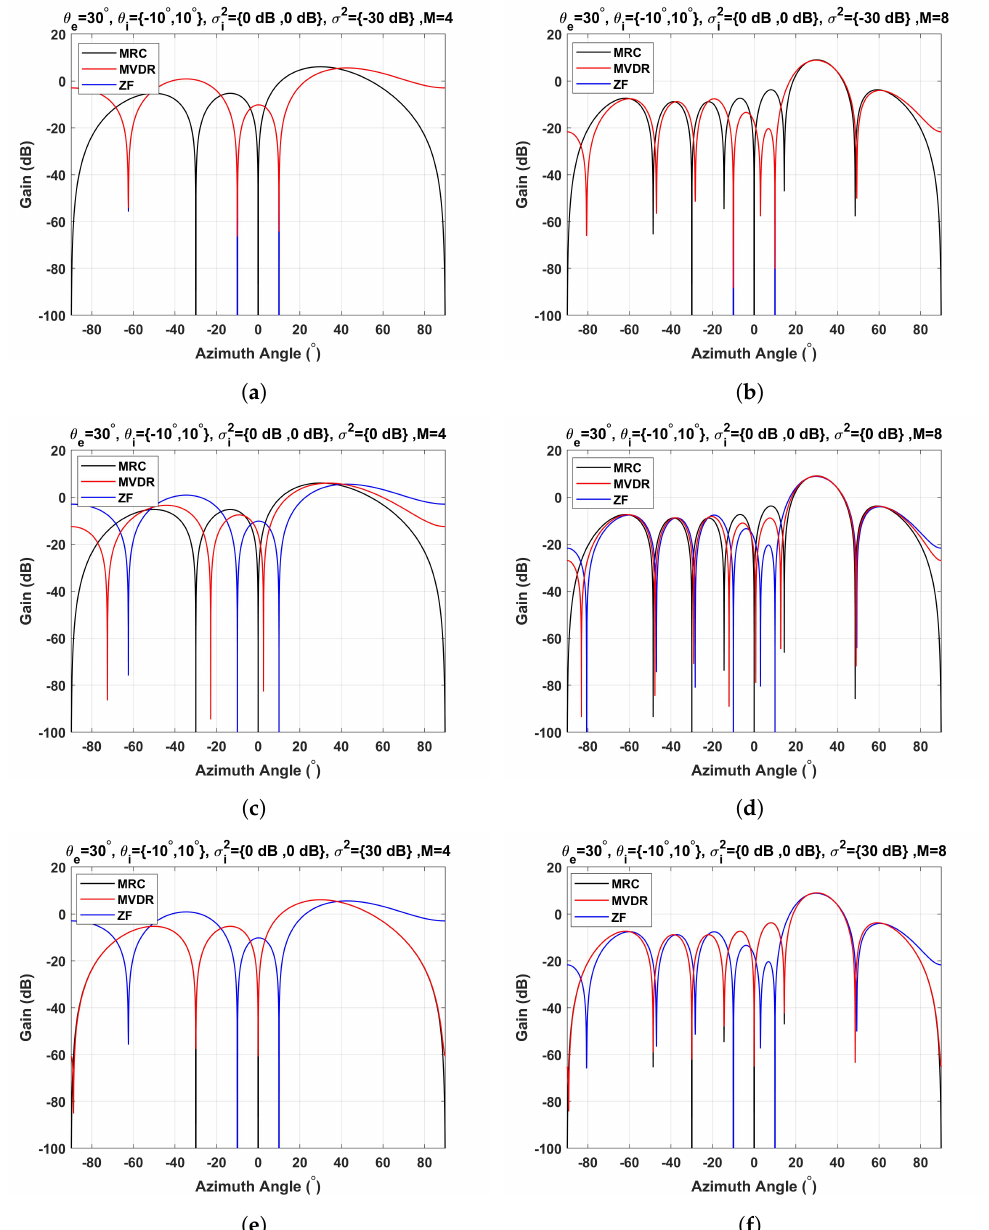
Figure 5. Beamforming techniques as a function of the number of array elements and the noise power (steering angle of 30 ◦ ): ( a ) M = 4, σ 2 = − 30 dB; ( b ) M = 8, σ 2 = − 30 dB; ( c ) M = 4, σ 2 = 0 dB; ( d ) M = 8, σ 2 = 0 dB; ( e ) M = 4, σ 2 = 30 dB; ( f ) M = 8, σ 2 = 30